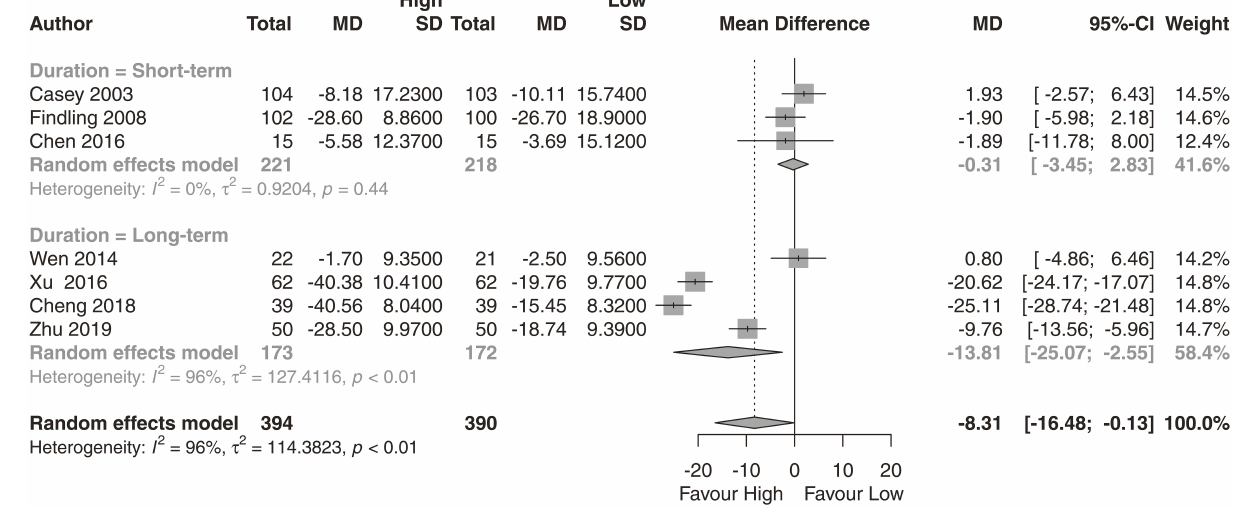
FIGURE 2 | PANSS total score. High, high-dose strategy; Low, low-dose strategy.